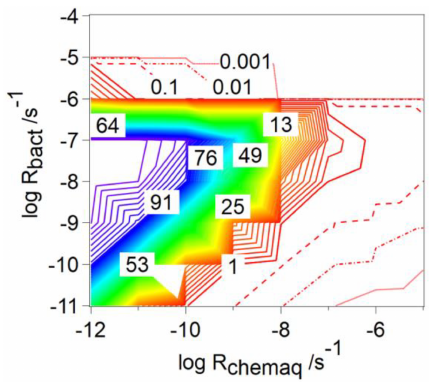
Figure 3. Relative contribution of bacteria to the total loss rate of CCN-derived organics (fr bact , Eq. 7) as a function of R bact [s − 1 ] and R chemaq [s − 1